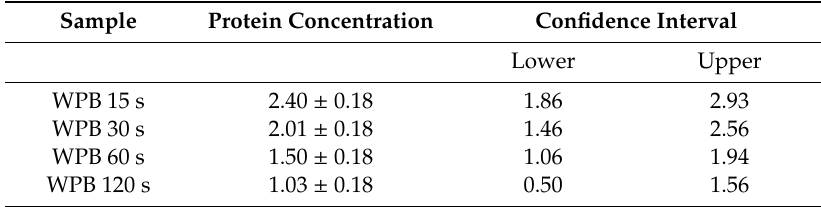
Figure A2. Protein concentration in saliva samples. Values are expressed as LSM estimates ± standard error from SAS output. Table A1. Volunteers protein concentration (mg/mL) in saliva samples post whey protein beverage (WPB) consumption with corresponding 95% confidence intervals.